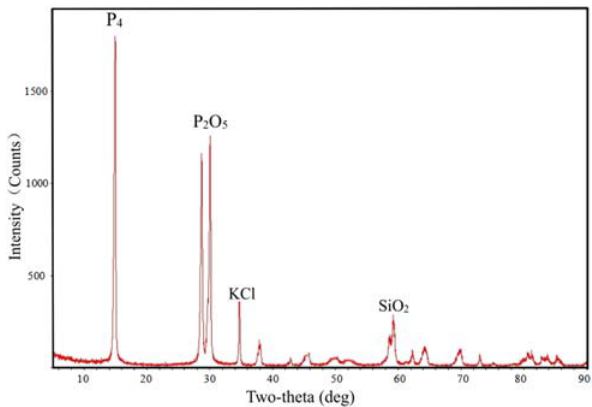
Figure 3: XRD detection